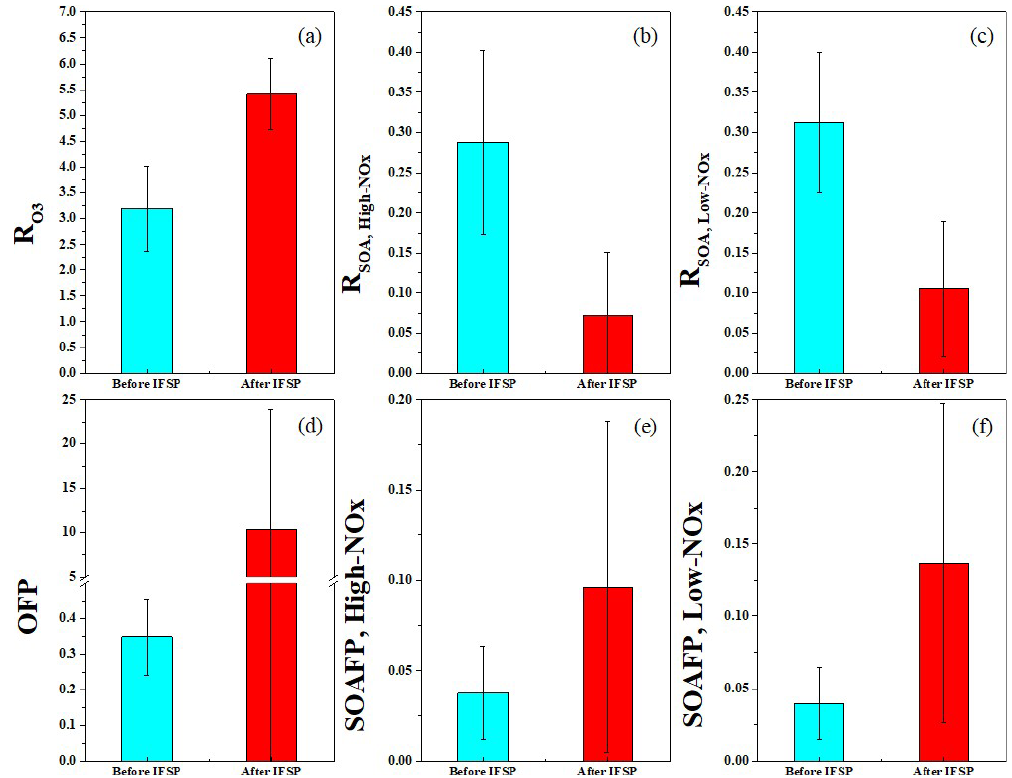
Figure 5. The changes in R O 3 (gO 3 g − 1 VOCs), R SOA (gSOAg − 1 VOCs), OFP (gO 3 kg − 1 fuel) and SOAFP (gSOAkg − 1 fuel) for coastal vessels before and after